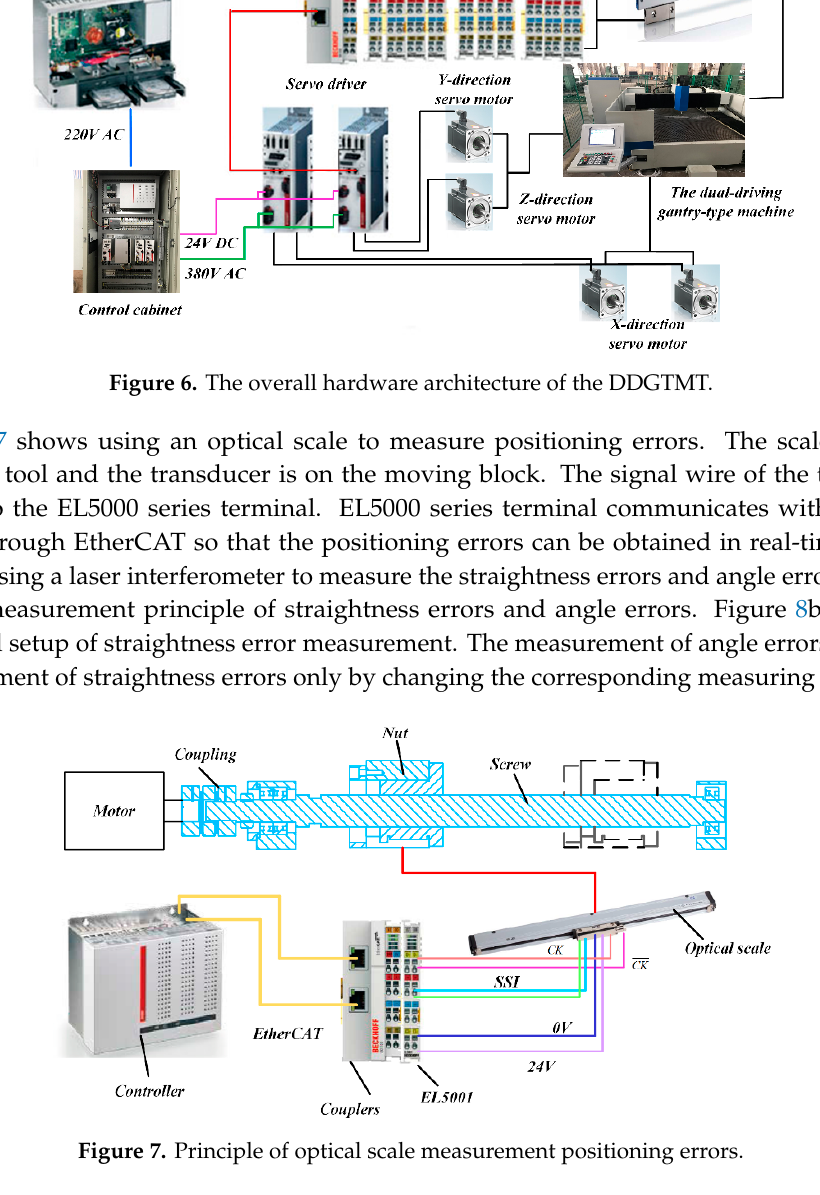
Figure 8. The experimental diagram of error measurement. ( a ) Principle of straightness errors and angle error measurement; ( b ) the experimental setup of straightness errors